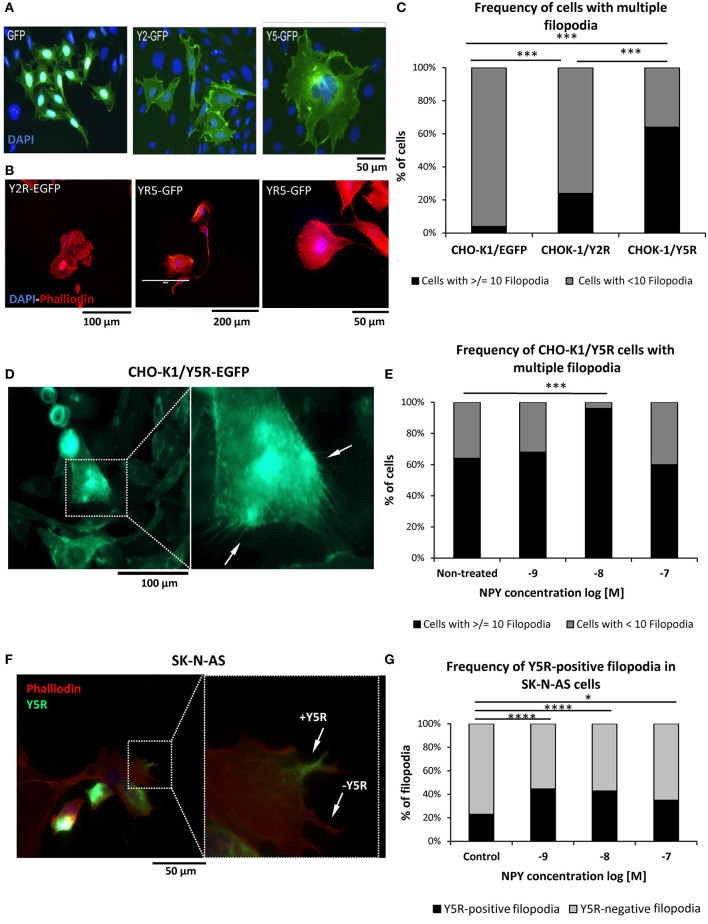
The NPY/Y5R axis contributes to filopodia formation. (A) Representative microscopic images of CHO-K1 cells transfected with EGFP alone or fused to Y2R or Y5R. (B) Representative images of CHO-K1/Y2R-EGFP and CHO-K1/Y5R-EGFP cells stained with Texas Red®-X phalloidin. (C) Frequency of cells with multiple filopodia (10 or more per cell) in CHO-K1/EGFP, CHO-K1/Y2R-EGFP, and CHO-K1/Y5R-EGFP cell lines. (D) A representative image of CHO-K1/Y5R-EGFP cells with multiple filopodia. (E) Effect of NPY on the frequency of CHO-K1/Y5R-EGFP cells with multiple filopodia. (F) A representative image of SK-N-AS NB cells with Y5R-postive and Y5R-negative filopodia stained with anti-Y5R antibody (green) and phalloidin (red). (G) Frequency of Y5R-positive filopodia in SK-N-AS cells with or without NPY (10−9-10−7 M). Panels (C,E,G): *p < 0.05, ***p < 0.001; ****p < 0.0001 by Chi-square test; results shown as a percent of cells (C,E) or filopodia (G); n = 25 per condition. CHO-K1/Y5R-EGFP and SK-N-AS shown and analyzed in (C–G) were cultured in wound healing assay chambers, and only cells at the migratory edges of wounds were analyzed.